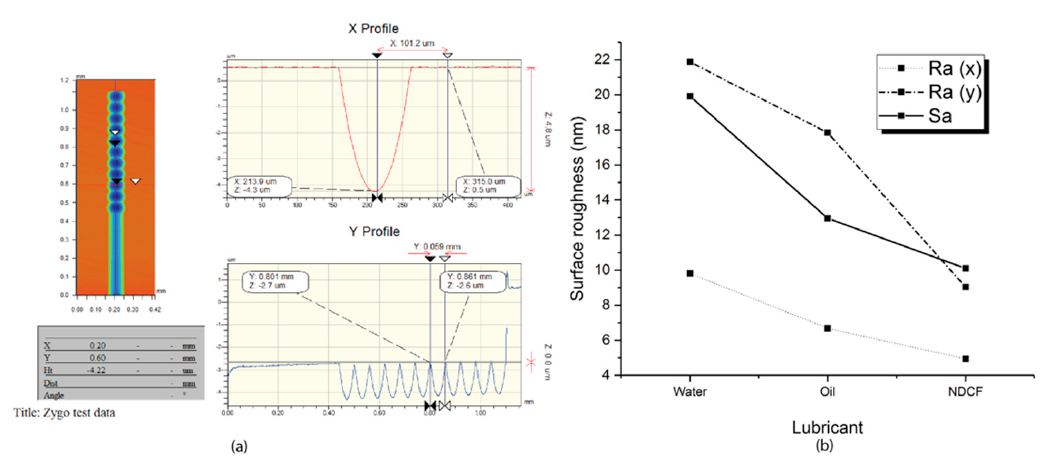
8 of 10 Figure 7. Effect of various cutting fluids on the cutting force in the taper cutting: ( a ) water; ( b ) oil; ( c ) NDCF. 4. Discussion Experiments were implemented to machine a test piece with 10 microlenses in a straight line, each of which had a tool radius of 0.3 mm. A microlens array on the PMMA was machined under conditions similar to those of the taper cutting experiments. A 1 mm-long straight tool path was designed, and 10 microlenses were machined continuously in a simple array. Three sets of microlenses were machined with different cutting fluids. Ten microlenses were machined on each test piece to have sufficient samples for evaluation of the surface cut with different cutting fluids. Specifically, the employment of NDCF as the cutting fluid contributed to the smallest surface